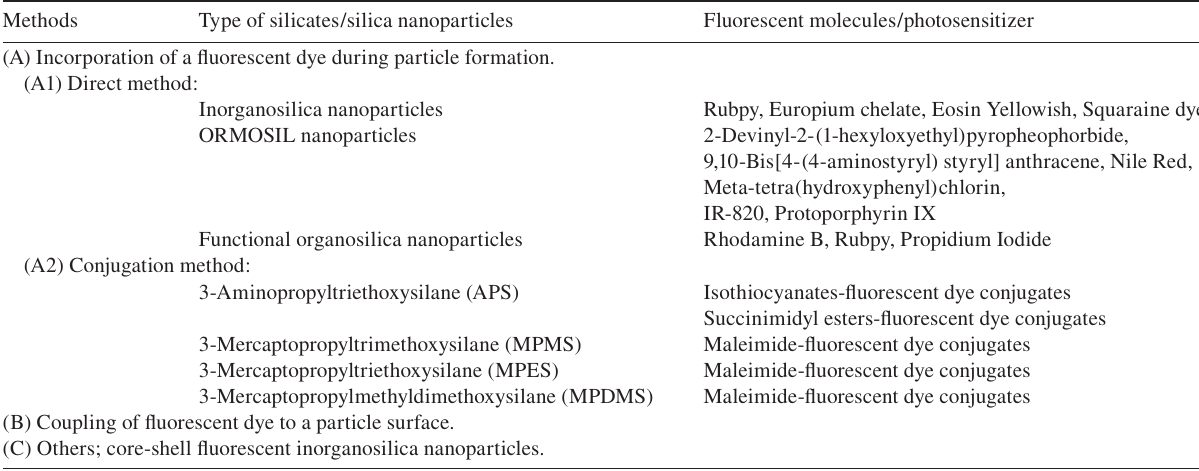
Table 2 Classifi cation of fl uorescent silica nanoparticles.